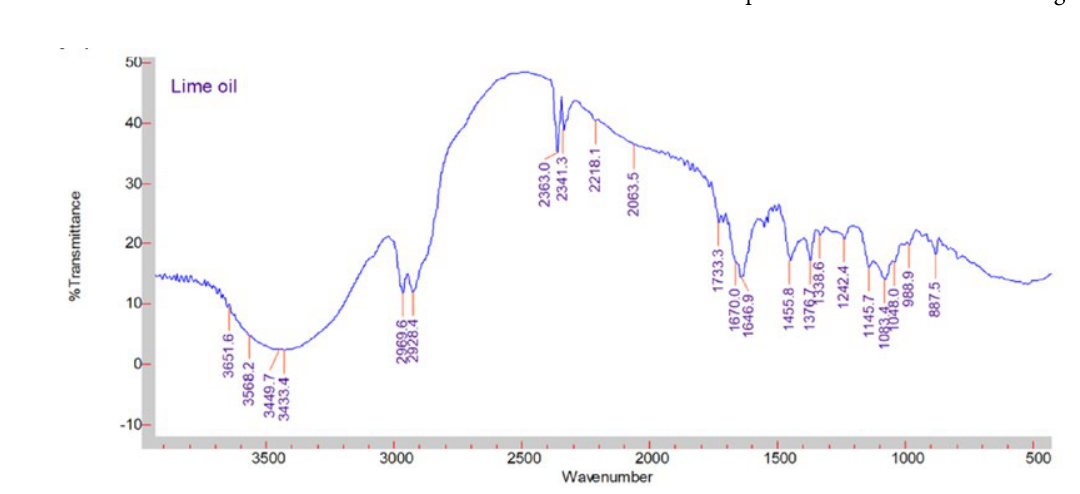
Figure 1 . FT-IR spectrum of unencapsulated lime oil